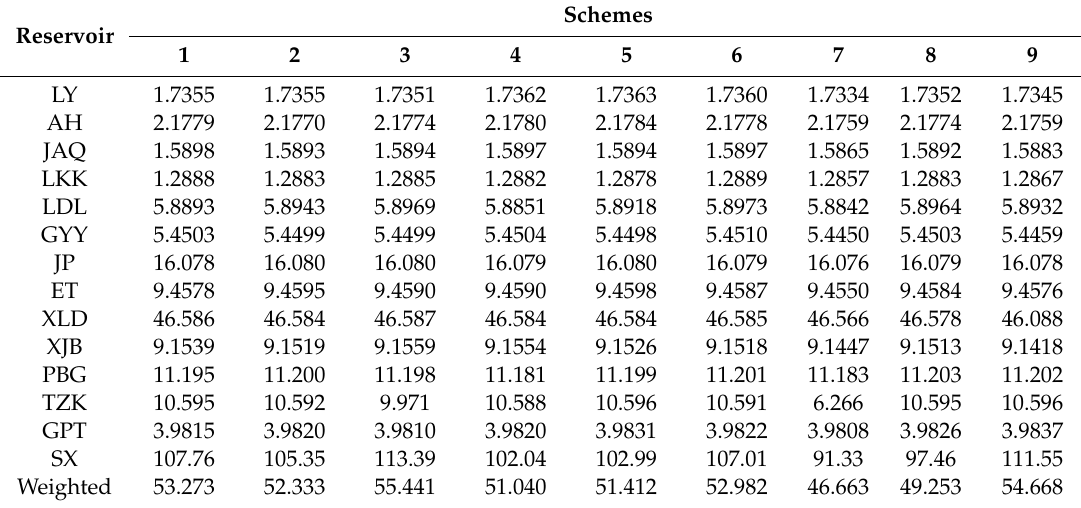
Table 4. The CVaR values of the maximum occupied capacity of each reservoir under the operation of di ff erent schemes.